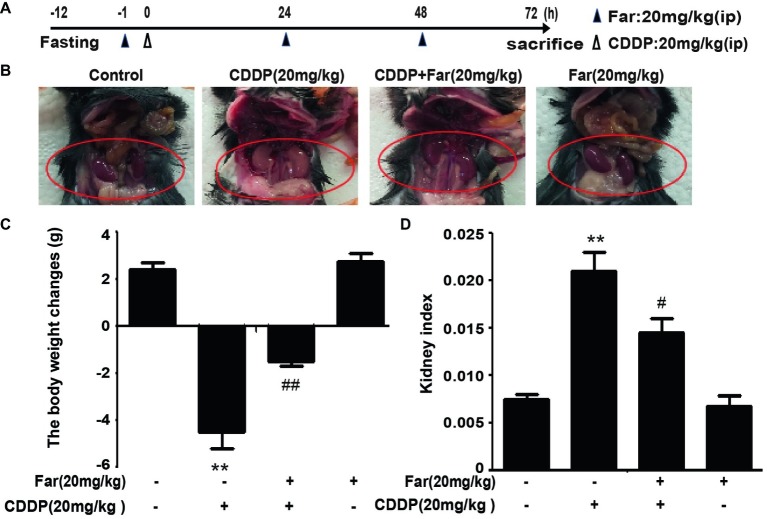
Effects of farrerol on cisplatin-induced AKI. (A) Experimental design and schedule for treatment with cisplatin alone or in combination with farrerol. After 12 h of fasting, C57BL/6 mice were treated with farrerol (20 mg/kg) and administered 20 mg/kg cisplatin or vehicle 1 h later via intraperitoneal injection. Farrerol was administered 24 and 48 h after injection, and the mice were sacrificed 24 h after the last dose of farrerol. (B) Images of kidneys without magnification. (C) The changes in body weight were calculated by subtracting the body weight at 72 h from and the body weight 1 h prior to treatment. (D) The kidney index is expressed as the weight of the kidney divided by the body weight at 72 h. All the data are presented as the means ± SEM (n = 10 per group). All experiments were duplicated three times. *p < 0.05 and **p < 0.01 vs. the control group; #p < 0.05 and ##p < 0.01 vs. the CDDP group.